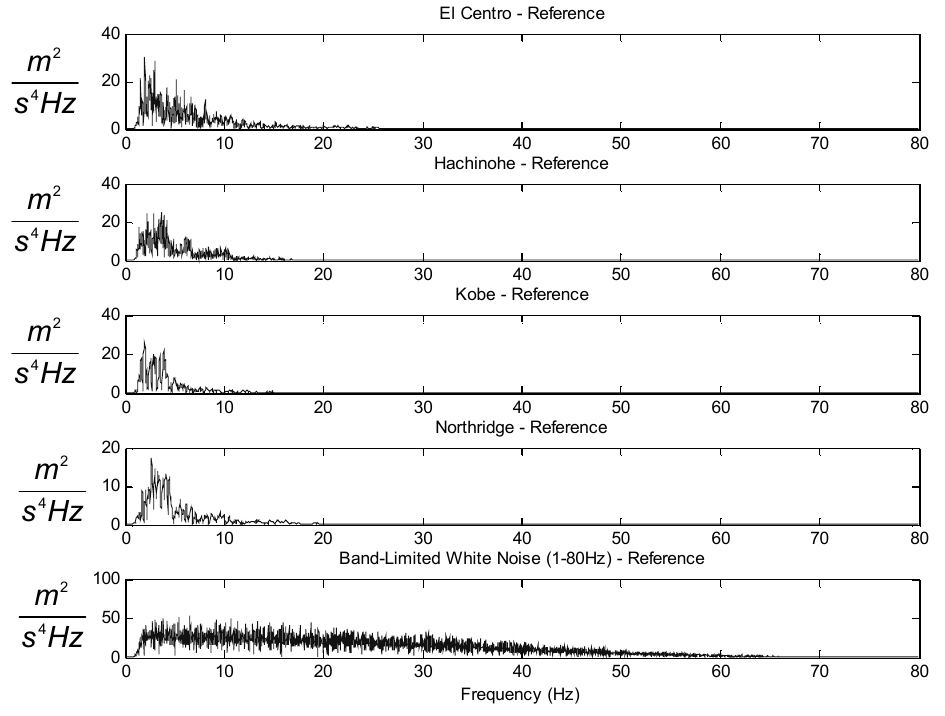
Fig. 2. FFT of reference input acceleration time